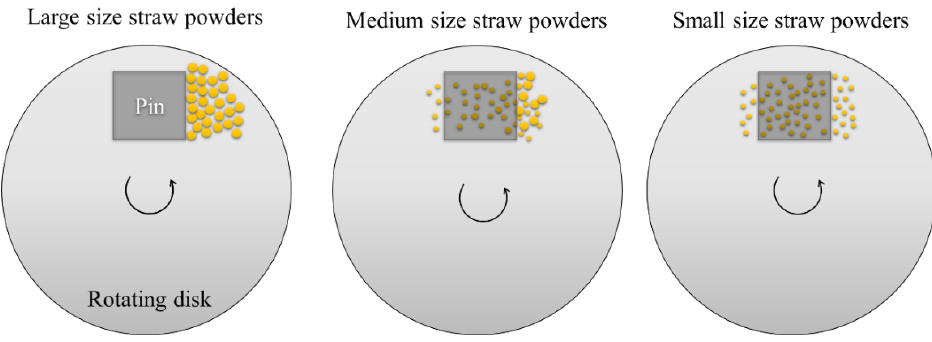
Figure 5. Movement of straw powder with different particle sizes during friction.